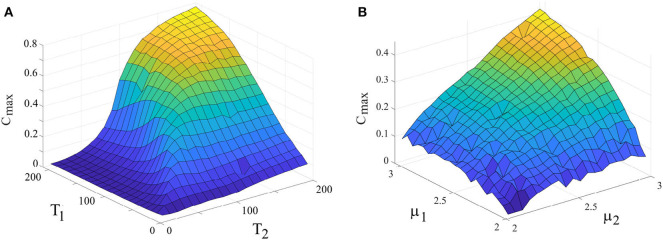
(A) Dependence of Cmax (as a measure for synchronization) on the periodicity of the drive and driven systems. μ1 = μ2 = 2.5. r2 = 0.025, L = 5 × 107. (B) Dependence of Cmax on the complexity index of the drive and driven systems. T1 = T2 = 50, r2 = 0.025, L = 5 × 107. Ensemble size = 1.